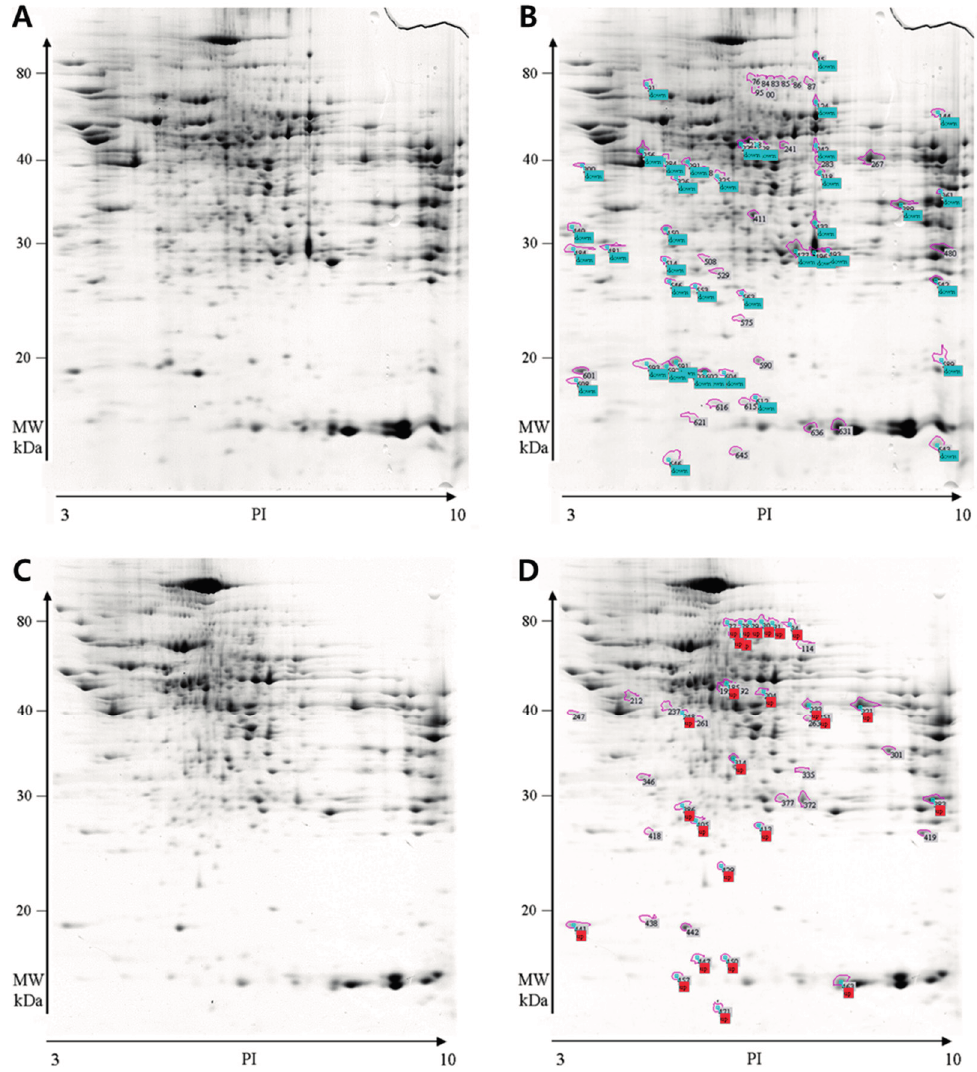
Figure 2. Two-dimensional electrophoretic gel images of cytoplasmic proteins. Spots indicated by spot number showed statistically significant differences in expression between the pair-fed and ethanol-fed group ( n = 5, p < 0.05). ( A , B ) pair-fed rat liver; and ( C , D ) ethanol-fed rat liver; down (blue in B ), down-regulated protein by ethanol consumption; up (red in D ), up-regulated protein by ethanol consumption.